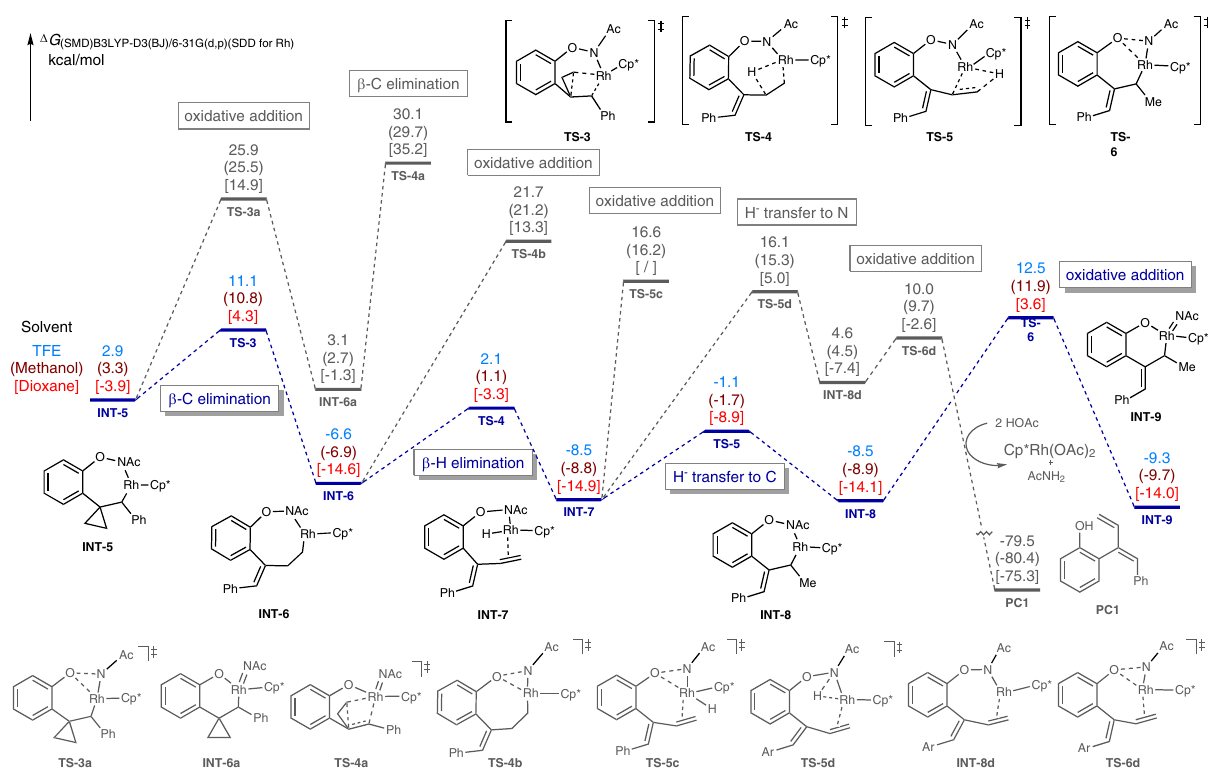
Fig. 8 Computed Gibbs free energy changes of the reaction pathways for β -C elimination, β -H elimination, Rh-H reinsertion, and oxidative addition in the reaction solvents (TFE, MeOH, and dioxane). The corresponding free energy pro fi les of different solvents were presented as follows: blue values for TFE, brown values in the parentheses for methanol, and red values in the square brackets for Supplementary Fig. 1 in the Supplementary Information for